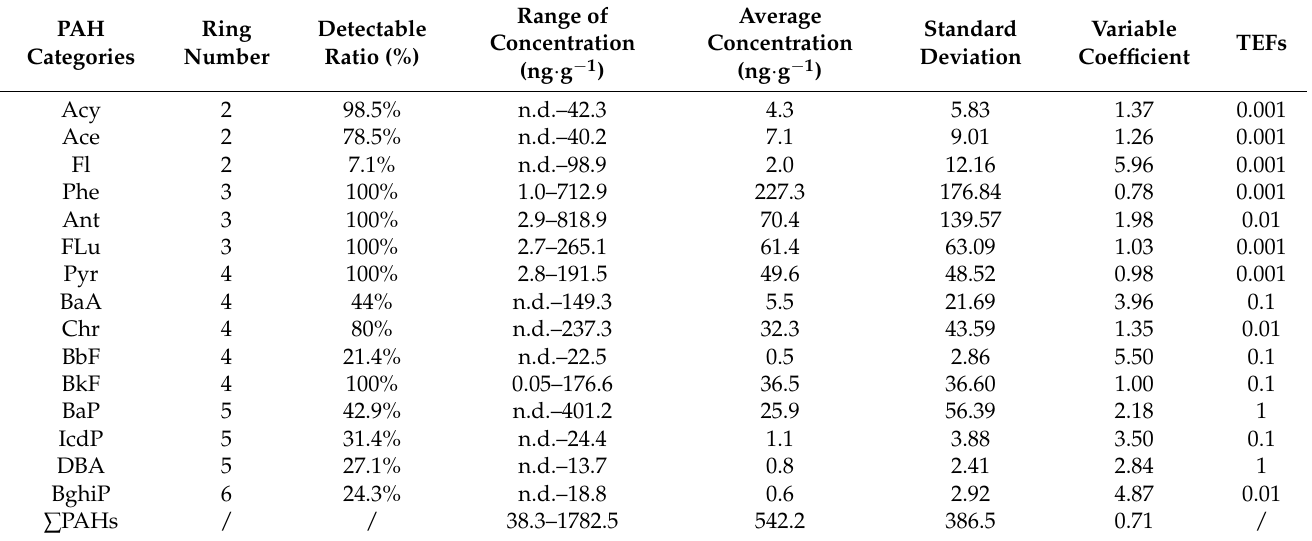
Table 3. Statistical detection ranges of the individual PAHs in all soil